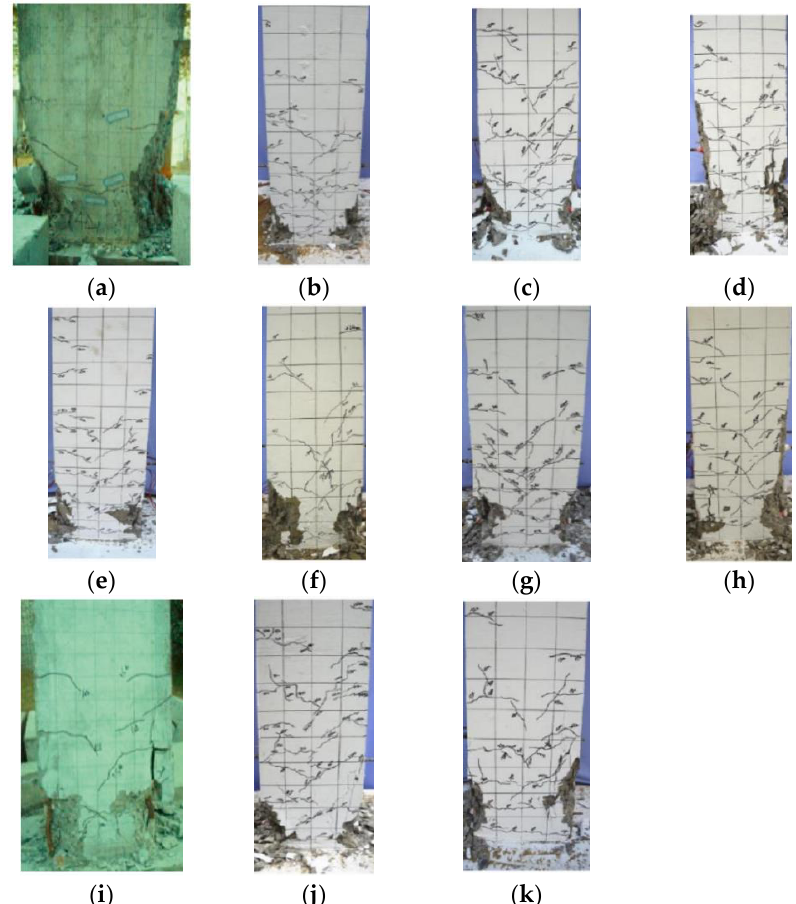
Figure 3. Flexural failure modes of test specimens. ( a ) NCCC-1 [42]; ( b ) NAC-0.30-40 [43]; ( c ) NAC-0.30-60 [43]; ( d ) NAC-0.30-100 [43]; ( e ) RAC50-0.30-40 [43]; ( f ) RAC50-0.30-60 [43]; ( g ) RAC50-0.30-100 [43]; ( h ) RAC100-0.30-60 [43]; ( i ) RCCC-2 [42]; ( j ) RAC50-0.15-60 [43]; and ( k ) RAC50-0.45-60 [43].